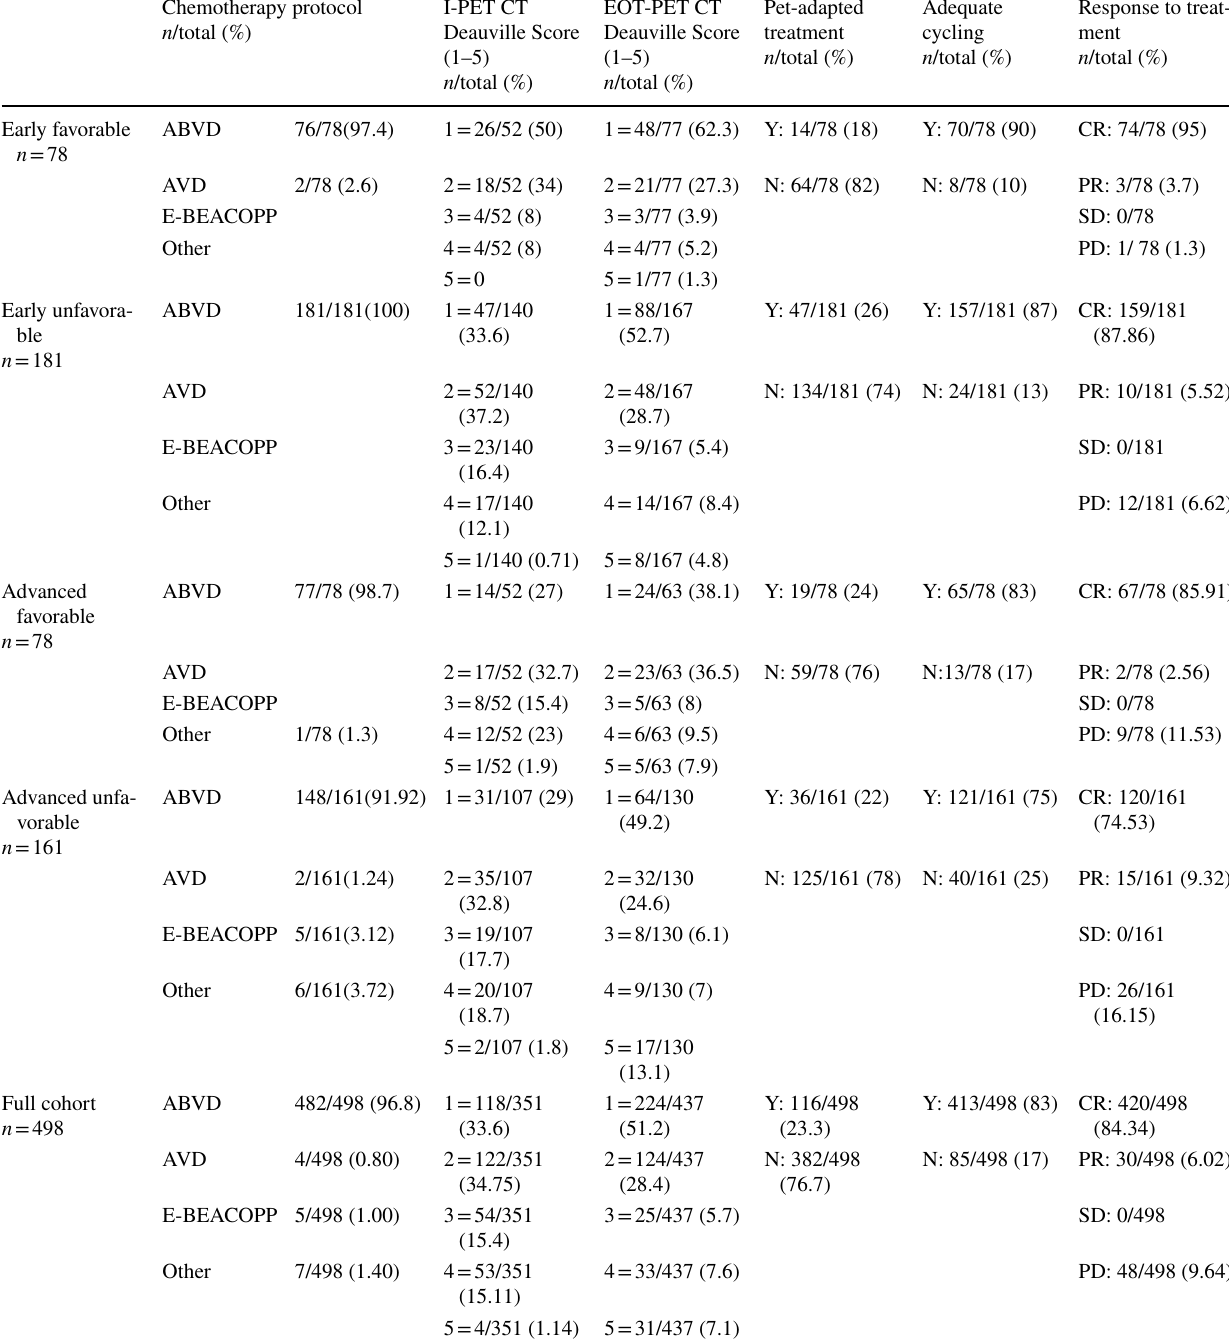
Table 2 Therapeutic strategy and outcome according to risk group and, in the full